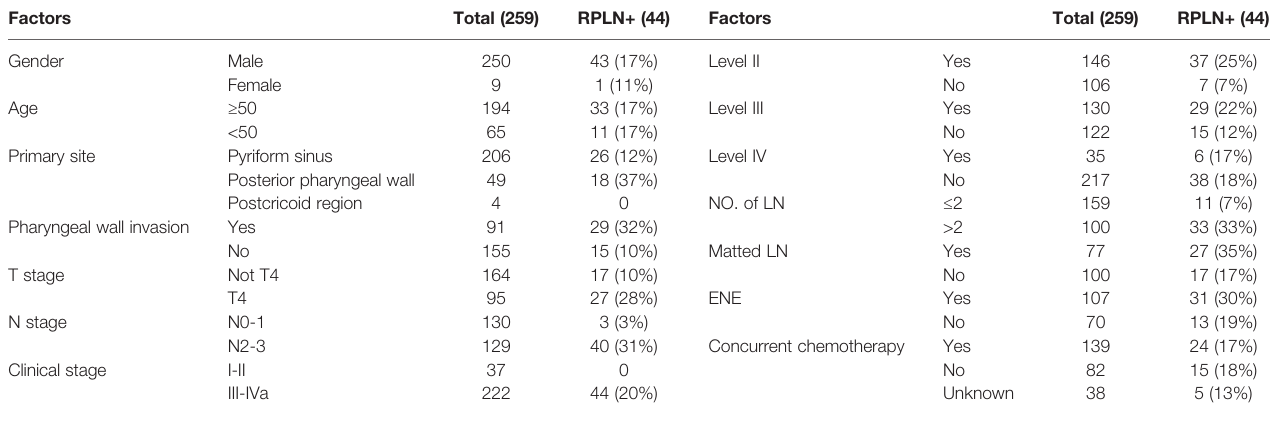
TABLE 1 | Baseline characteristics and treatment data of all the patients and those combined with RPLN metastasis. Factors